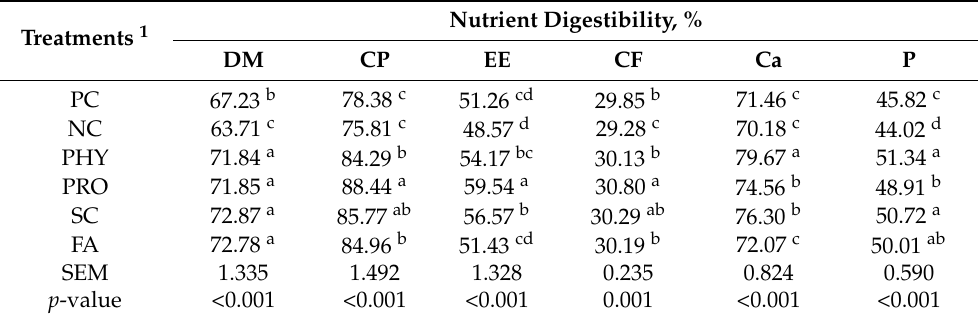
Table 5. Nutrient digestibility of broiler chickens fed a reduced nPP diet supplemented with phytase, probiotic, Saccharomyces cerevisiae , and fumaric acid at 35 days of